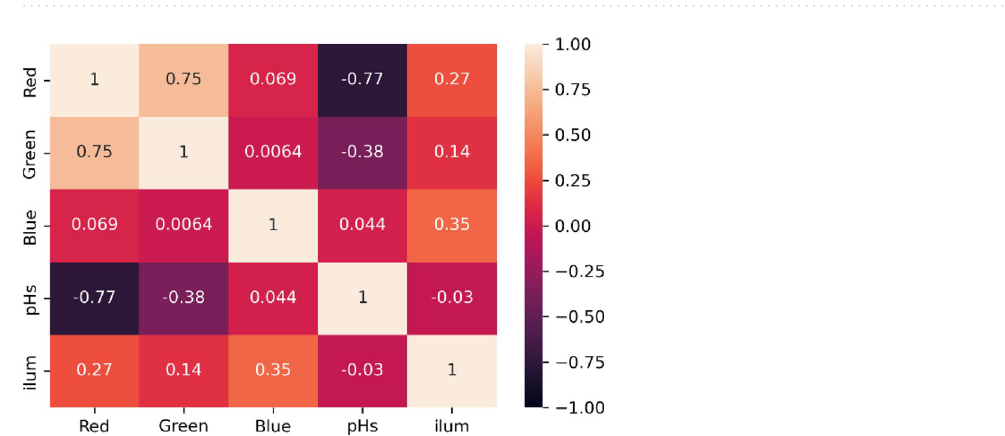
Figure 3. Exploratory Data Analysis of changed RGB code in different illuminated workplaces at (20, 200, and 350 Lux).